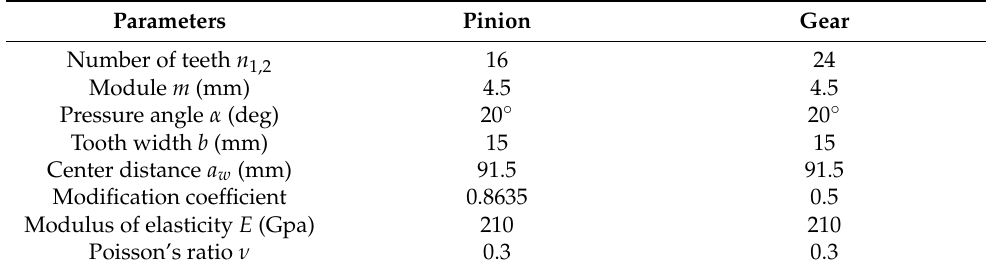
Table 1. Parameters required for calculation.